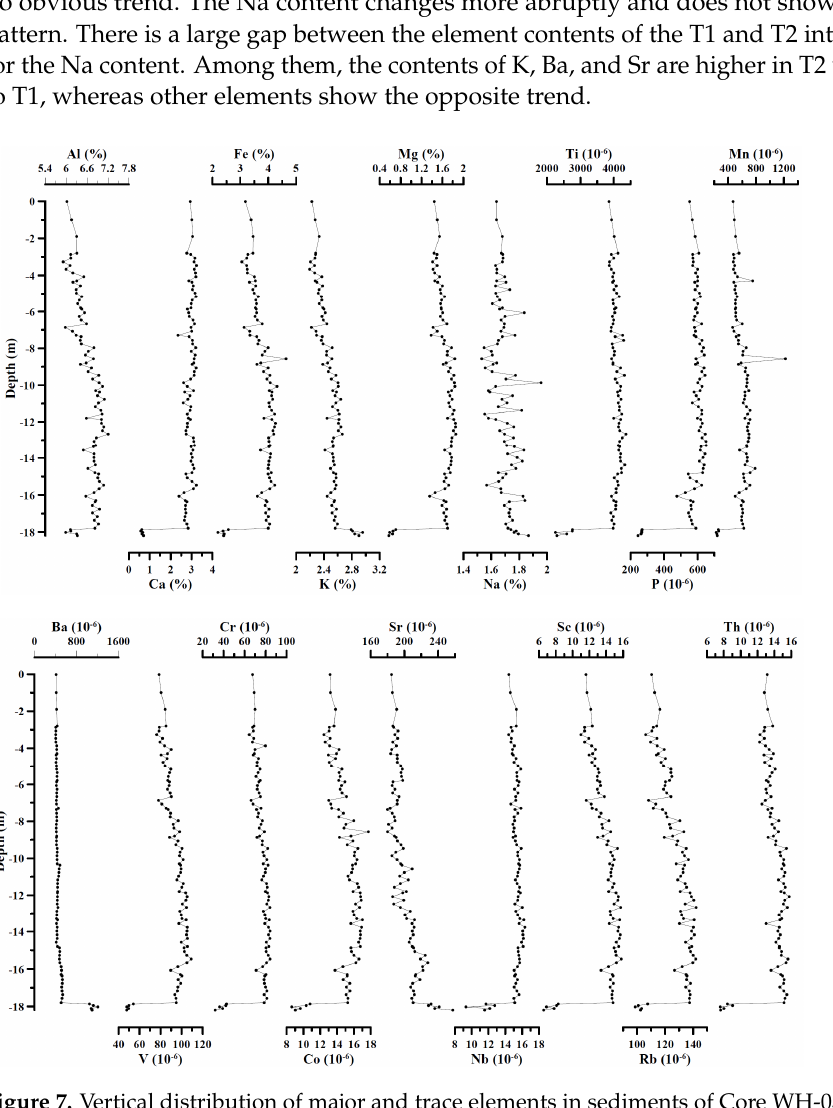
Figure 7. Vertical distribution of major and trace elements in sediments of Core